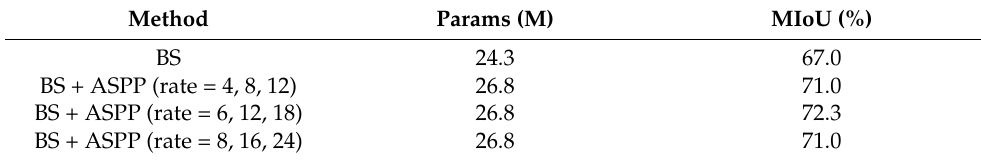
Table 3. The ablation study for the ASPP analysis on the Cityscapes validation set. Method Params (M) MIoU (%) BS 24.3 67.0 BS + ASPP (rate = 4, 8, 12) BS + ASPP (rate = 6, 12, 18) BS + ASPP (rate = 8, 16, 24) 26.8 71.0